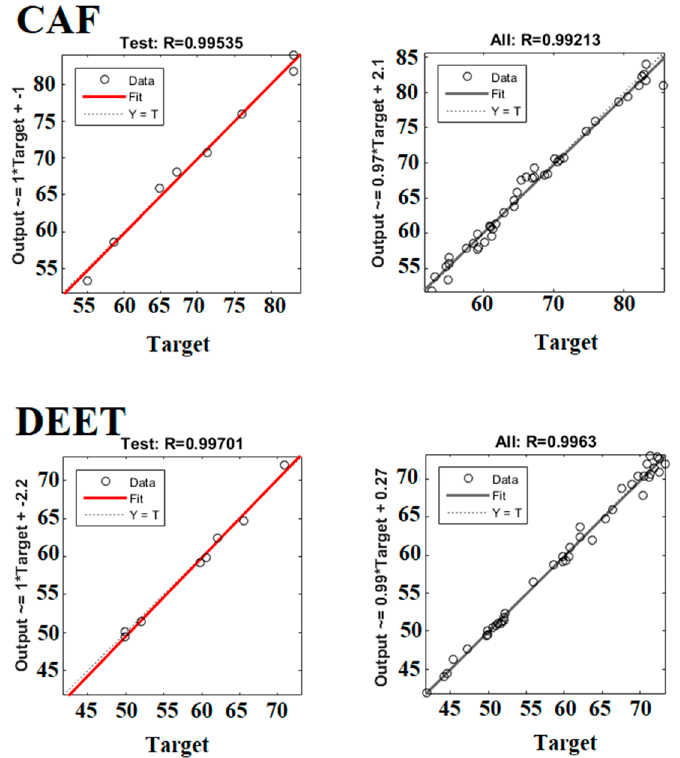
Figure 4. Prediction versus experimental values for the optimum analysis of the test and all data for the elimination of CAF and DEET in reactor 1.